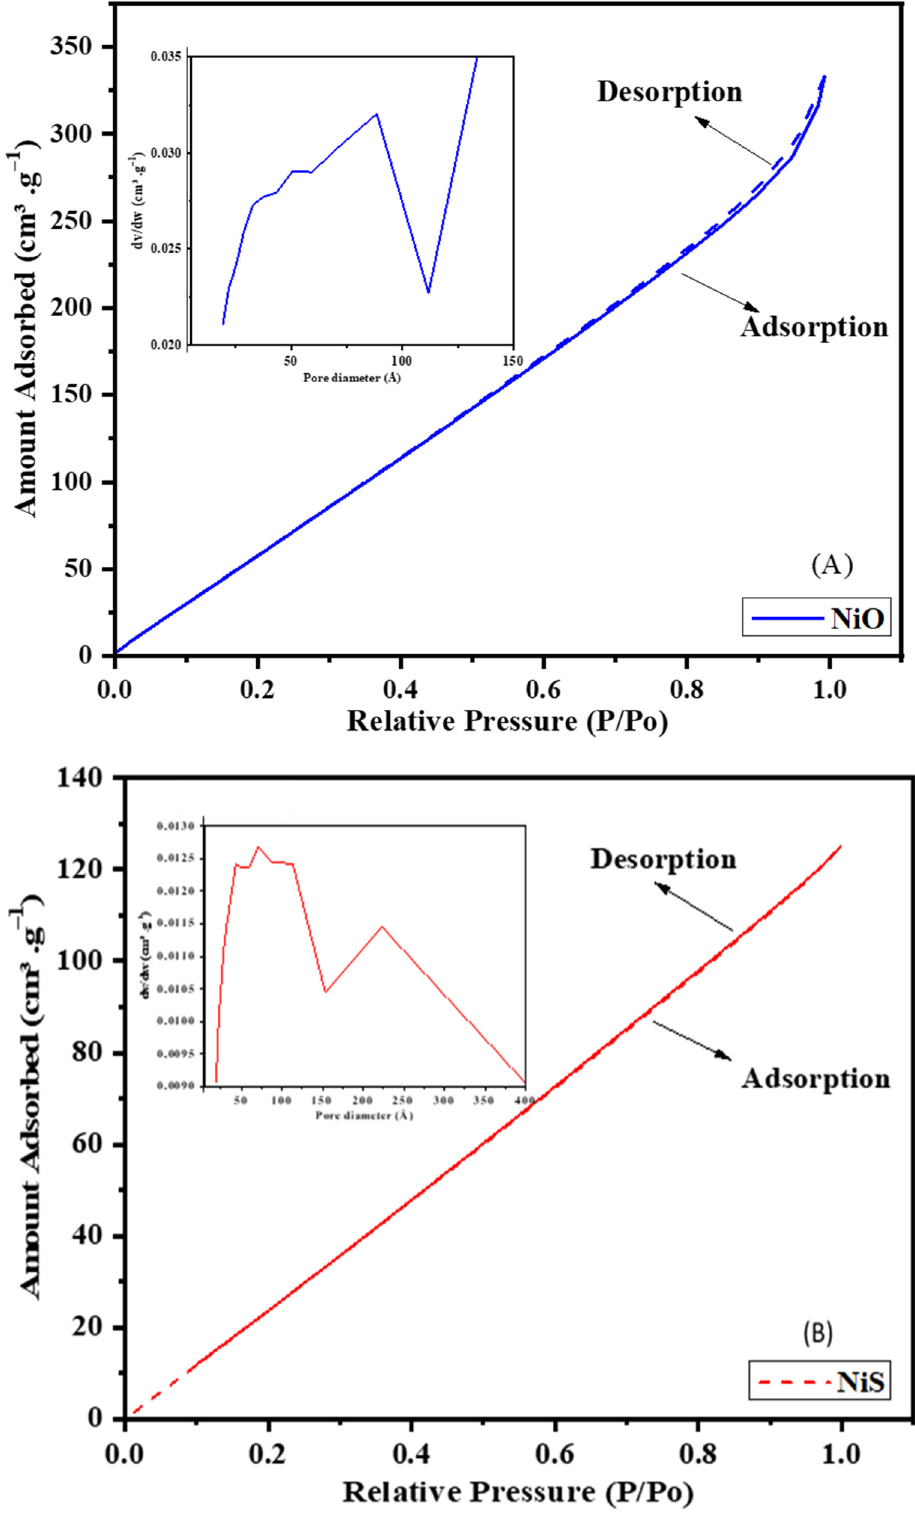
Figure 13. N 2 -physisorption of NiO and NiS isotherms (pore size distributions are shown in in- sets). Table 7. Specific surface area and porosity parameters of NiO and NiS.